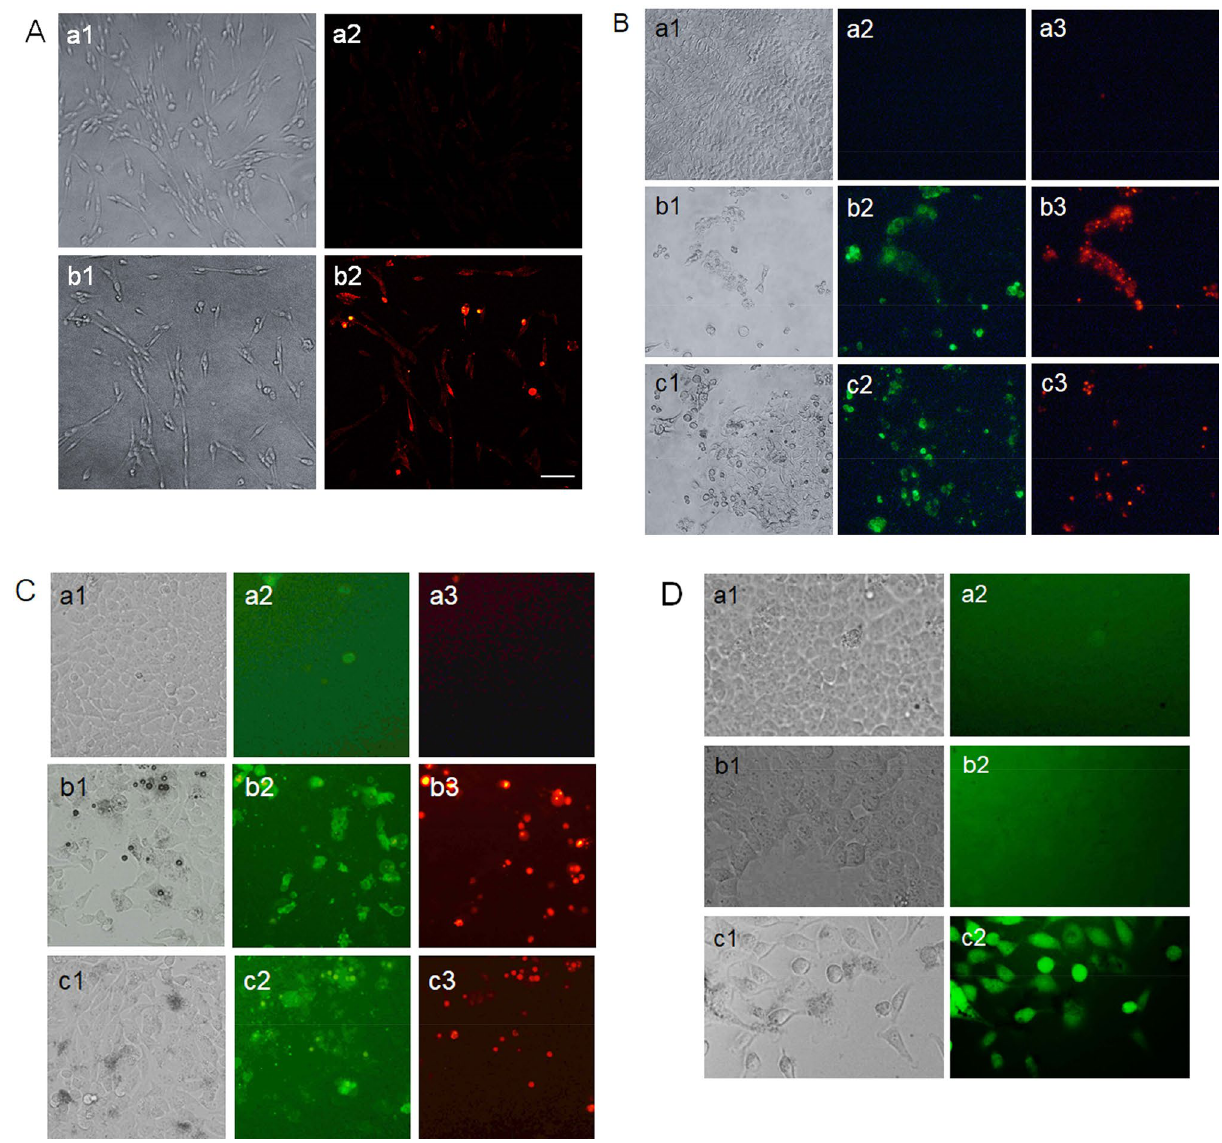
Figure 4. Cell morphological studies by the fluorometric assays. ( A ) Detection of apoptosis in GSCs by immunofluorometric assay. Where a1 and b1 represent the optical microscopic images of the untreated and G. densiflorum -Ag/AgCl-NPs treated GSCs, respectively; a2 and b2 represent the fluorescence microscopic images of the untreated and G. densiflorum -Ag/AgCl-NPs treated GSCs, respectively after staining with Cy3 goat-anti Rabbit IgG antibody. ( B ) Detection of early and late apoptosis in BxPC-3 by FITC-annexin V/ PI. ( C ) Detection of early and late apoptosis in MCF-7 cells by FITC-annexin V/PI. In the Figures ( B ) and ( C ), a1, b1 and c1 indicate the optical microscopic images of untreated, G. densiflorum -Ag/AgCl-NPs and K. rotunda -Ag/AgCl-NPs treated cells, respectively; a2, b2 and c2 indicate the fluorescence microscopic images of untreated, G. densiflorum -Ag/AgCl-NPs and K. rotunda -Ag/AgCl-NPs treated cells, respectively after stained with FITC-annexin V; a3, b3, and c3 indicate the fluorescence microscopic images of untreated, G. densiflorum -Ag/AgCl-NPs and K. rotunda -Ag/AgCl-NPs, treated cells, respectively after stained with PI. ( D ) ROS generation in MCF-7 cells. Where a1, b1 and c1 represent the optical microscopic images of the untreated control, G. densiflorum -Ag/AgCl-NPs and K. rotunda -Ag/AgCl-NPs treated MCF-7 cells, respectively; a2, b2 and c2 represent the optical microscopic images of the untreated control, G. densiflorum -Ag/AgCl-NPs and K. rotunda -Ag/AgCl-NPs treated MCF-7 cells, respectively after stained with DCFH-DA. All image was captured at 20 × magnification. In Fig ( A ), the solid bar indicates 20